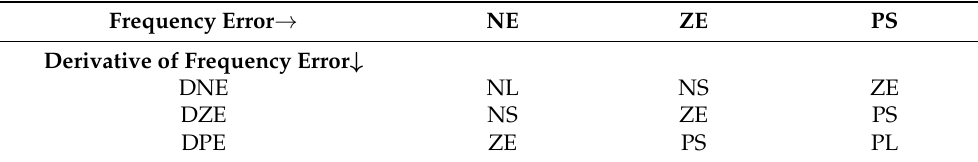
Table 3. Fuzzy rule-based